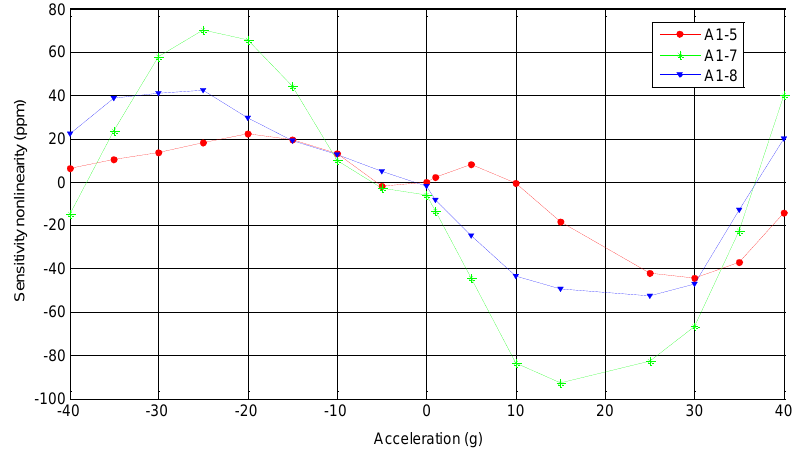
Figure 10. Testing nonlinearity of the sensitivity in the range of ±40 g.